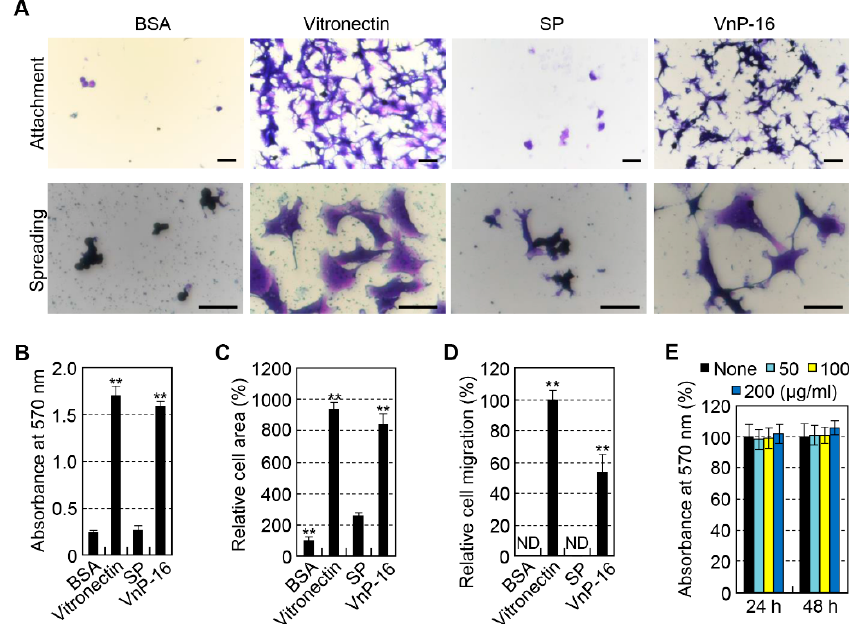
Figure 2. Cell attachment, spreading, and migration of osteoblast-like HOS cells seeded on culture plates treated with vitronectin and synthetic peptides. ( A ) Photographs of osteoblast-like HOS cells adhering (upper panel) and spreading (lower panel) to culture plates treated with 1% bovine serum albumin (BSA), vitronectin (0.26 µ g / cm 2 ), scrambled peptide (SP), and VnP-16 peptide (10.5 µ g / cm 2 ). Bar = 100 µ m. ( B , C ) Cell attachment ( B ) and spreading ( C ) to immobilized synthetic peptides. HOS cells were allowed to adhere to peptide-treated plates for 1 h ( B ) or 3 h ( C ) in serum-free medium. ( D ) Migration of osteoblast-like HOS cells induced by vitronectin and synthetic peptides. HOS cells were seeded into the upper chambers of transwell filters coated with vitronectin (0.26 µ g / cm 2 ), SP, or VnP-16 (10.5 µ g / cm 2 ) and were incubated for 24 h. ND, not detected. ( E ) The viabilities of osteoblast-like HOS cells treated with VnP-16 for 24 or 48 h. ** p < 0.01 vs. the SP-treated control group. Data in ( B – E ) ( n = 4) represent the mean ± SD.